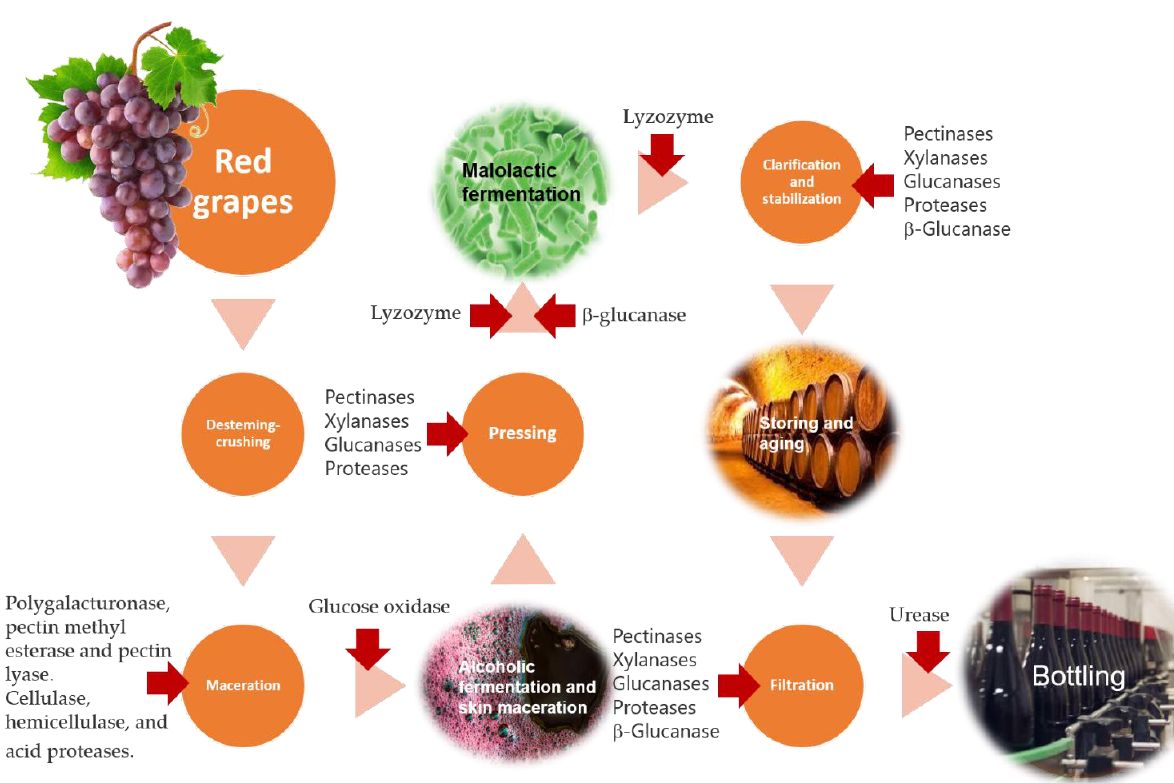
Figure 1. Schematic representation of red wine’s conventional production process, showing the stages at which enzymes could be added. Adapted from Ray et al. [70].